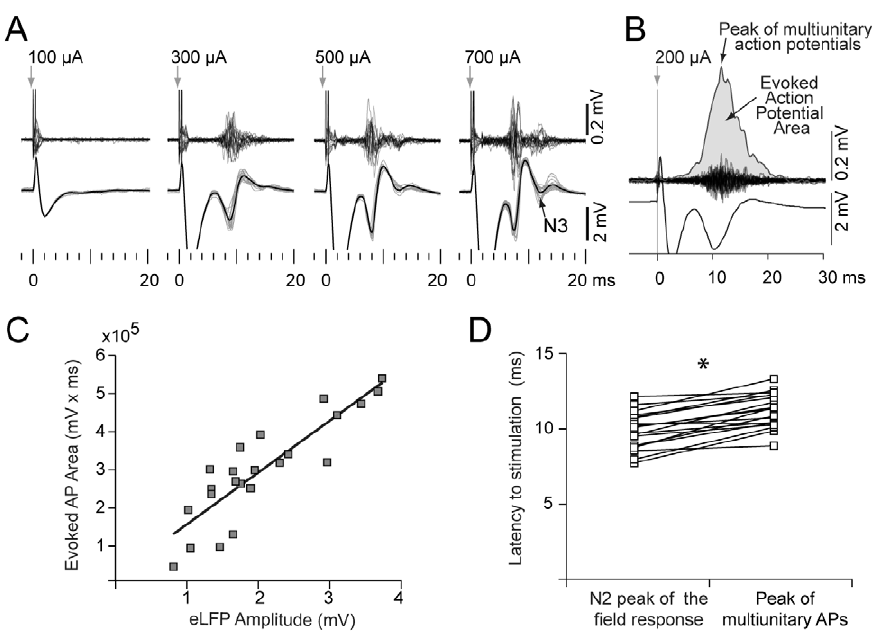
Figure 4. Evoked field response precedes the peak of multiunitary action potential response. A. Field (3–300 Hz) and action potential (300–3000 Hz) responses at the hot spot to increasing stimulation current intensities. Note the secondary field response (N3 peak, black arrow) at high stimulation intensities (20 trials at each intensity). B. To quantify the action potential response, trials were rectified, smoothed and averaged, allowing the computation of the area and peak latency of the multiunitary action potential response. C. Correlation between the amplitude of the evoked field potential and the area of the action potentials response at 300 m A; each point stems from one recording site at the hot spot from 23 different experiments. r 2 =0.84, p , 0.0001. D. Field response N2 peak precedes the peak of multiunitary action potential response (n=23, * p , 0.005, Student’s paired t test).